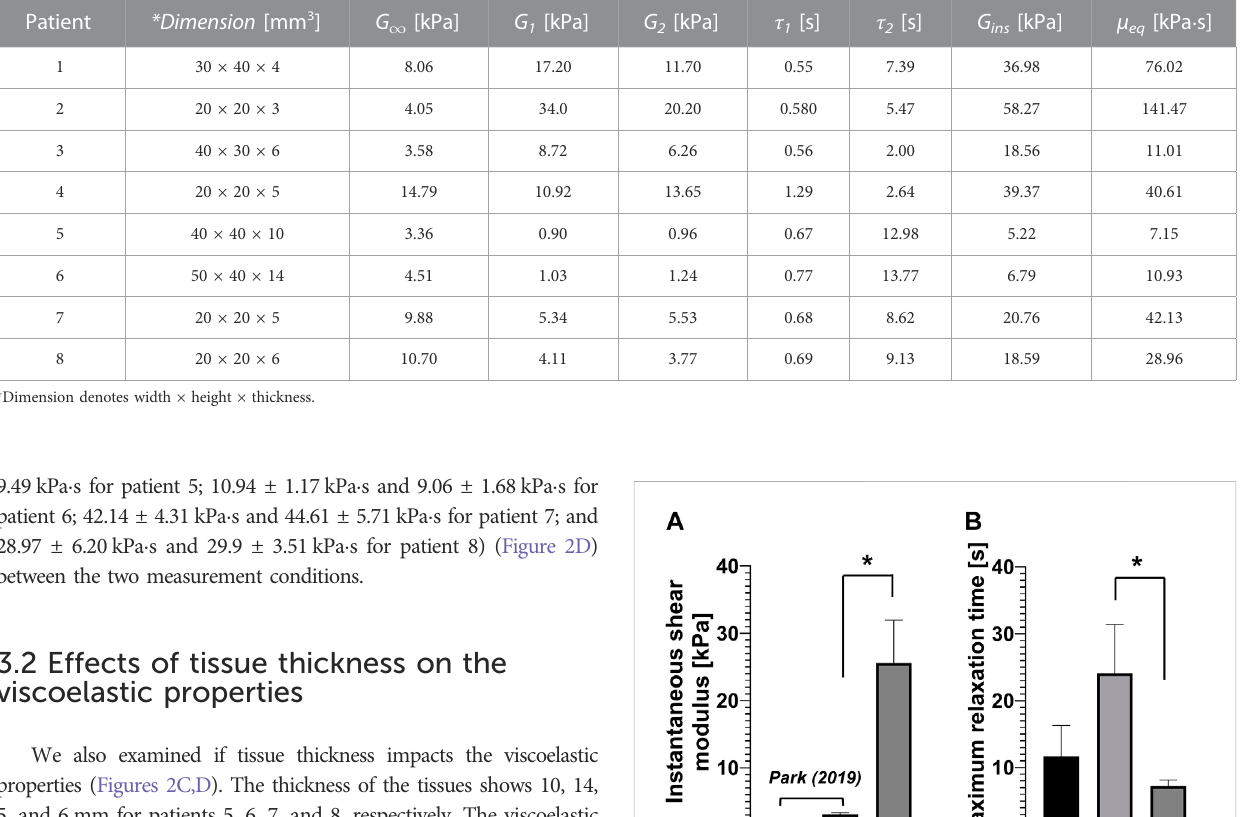
TABLE 1 Viscoelastic properties of human melanoma tissues from eight patients. Patient